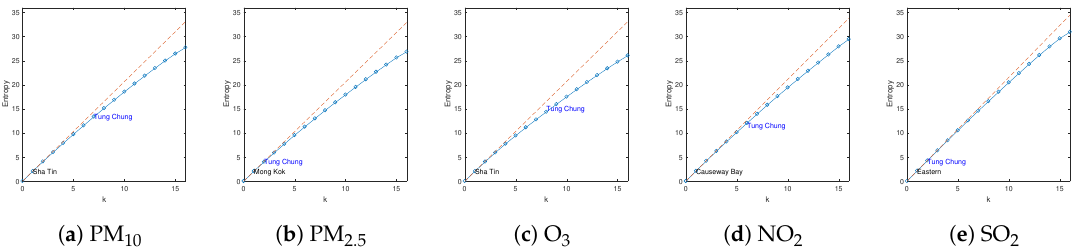
Figure 5. Comparison of information gain of different spatial fields with simple greedy